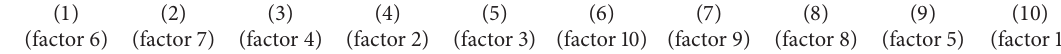
Table 4: Correlations among the ten factors.